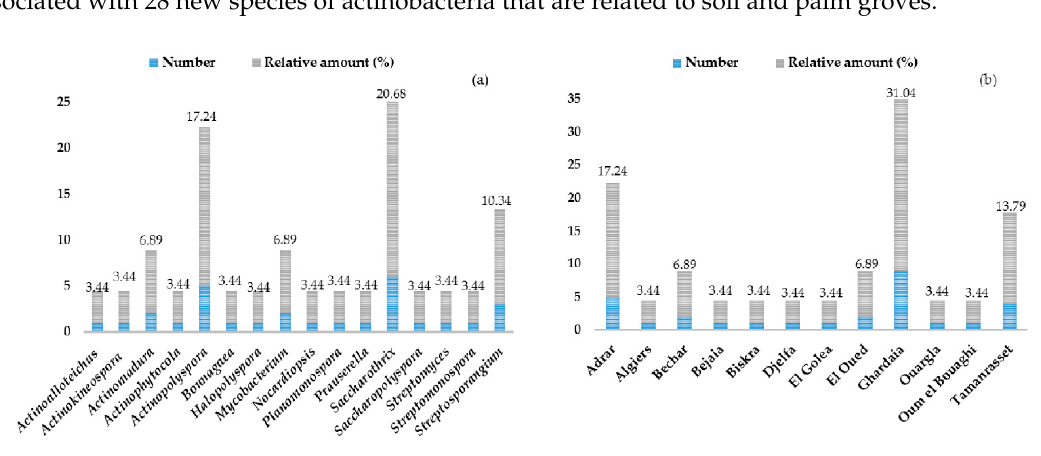
Figure 4. Proportion of novel species, genera, and rare actinobacteria strains from different Algerian ecosystems reported since 2002 ( a ), according to the places of collection ( b ). Details are in Figure 1. Table 1. List of novelly discovered rare actinobacteria species isolated from different ecosystems in Algeria since 2002.